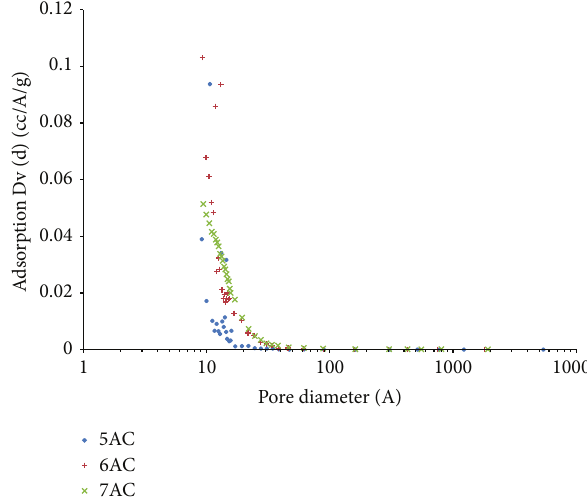
Figure 3: Results of PSD of palm shell activated carbon using BJH method.